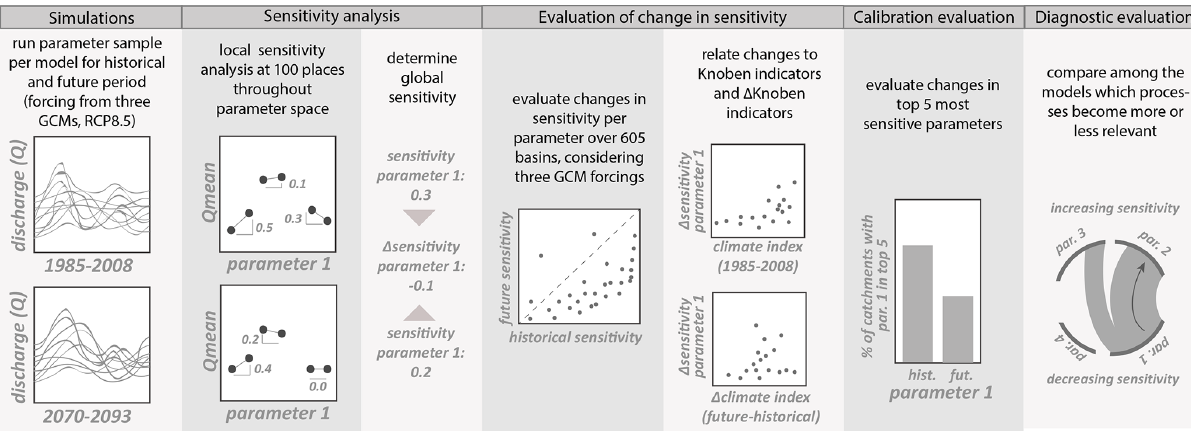
Figure 1. Summary of the methodological approach, to be read from left to right. The first three panels are the calculations, and the other four panels are the actual